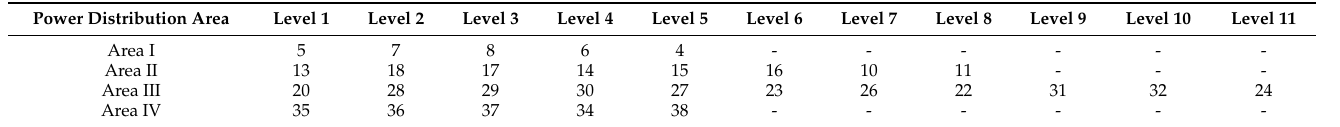
Table 3. Priority of EV access nodes in each power distribution